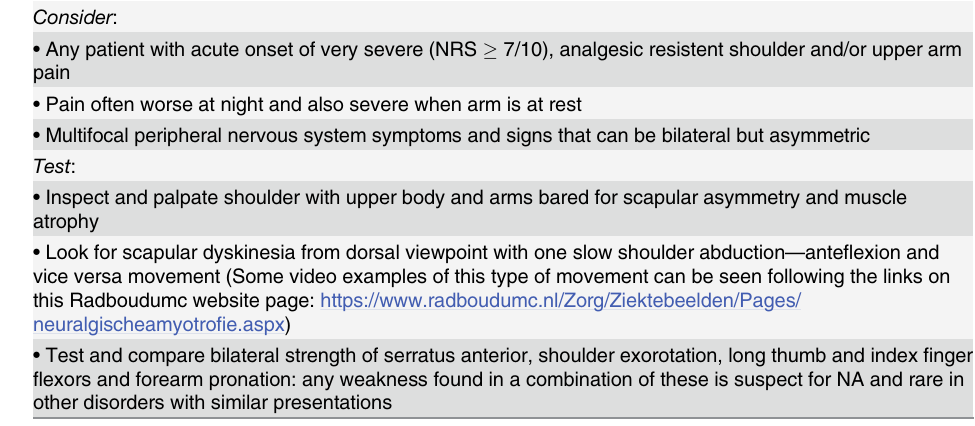
Table 4. Points that help making the correct diagnosis of neuralgic amyotrophy. Consider